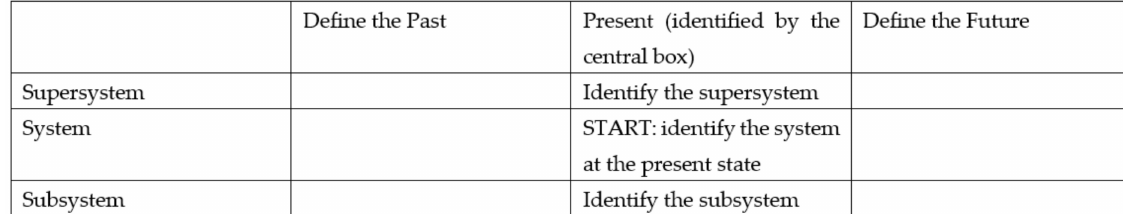
Figure 2. Questions to guide the construction of the